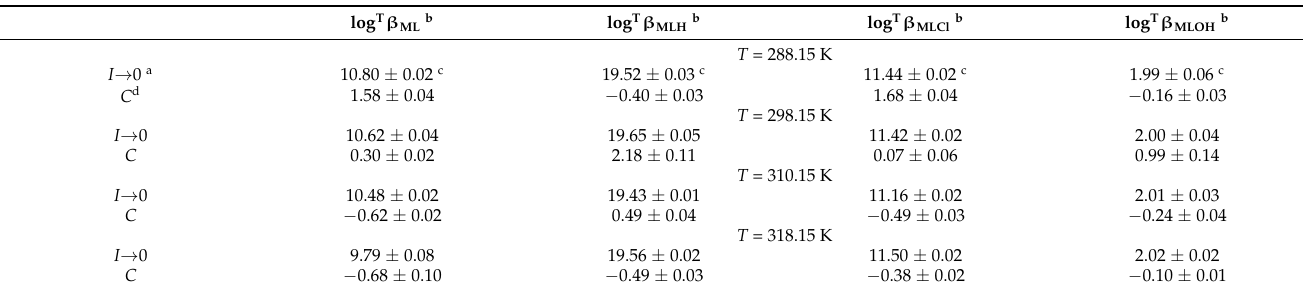
Table 7. Formation constants at infinite dilution and different temperatures of the CH 3 Hg + /Dop − species.